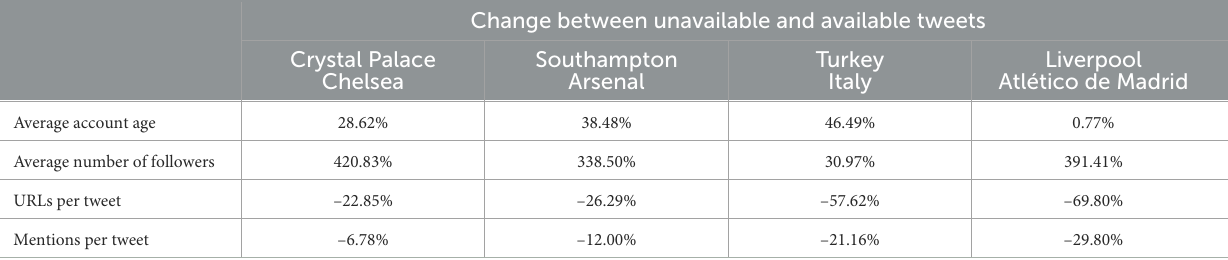
TABLE 4 The change in mean values of selected attributes between the sets of unavailable and available tweets. Change between unavailable and available